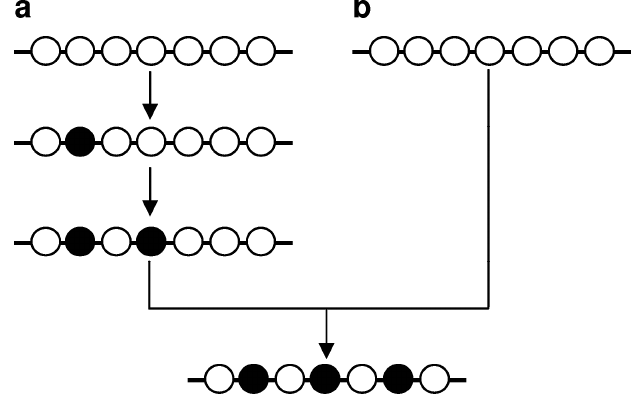
Figure 4. Two concepts for generating multiple mutations. Multiple mutations can accumulate during multiple cell cycles ( a ) or can be generated in the same cell cycle and in rapid succession ( b ). Adapted from